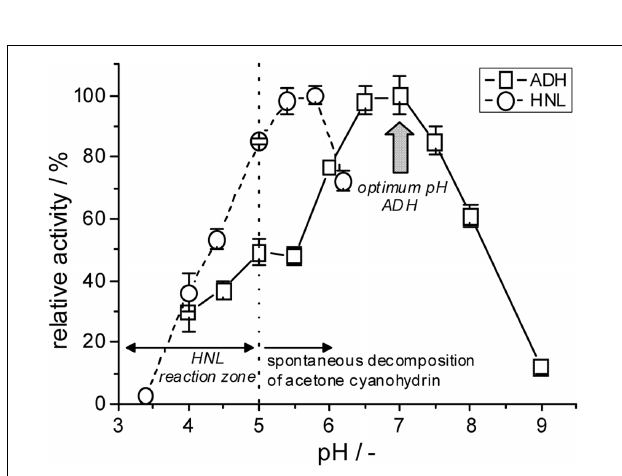
FIGURE 7 | Compartmented cascade reaction with Lk ADH in compartment A at pH 7 and Me HNL in compartment B at pH < 7.